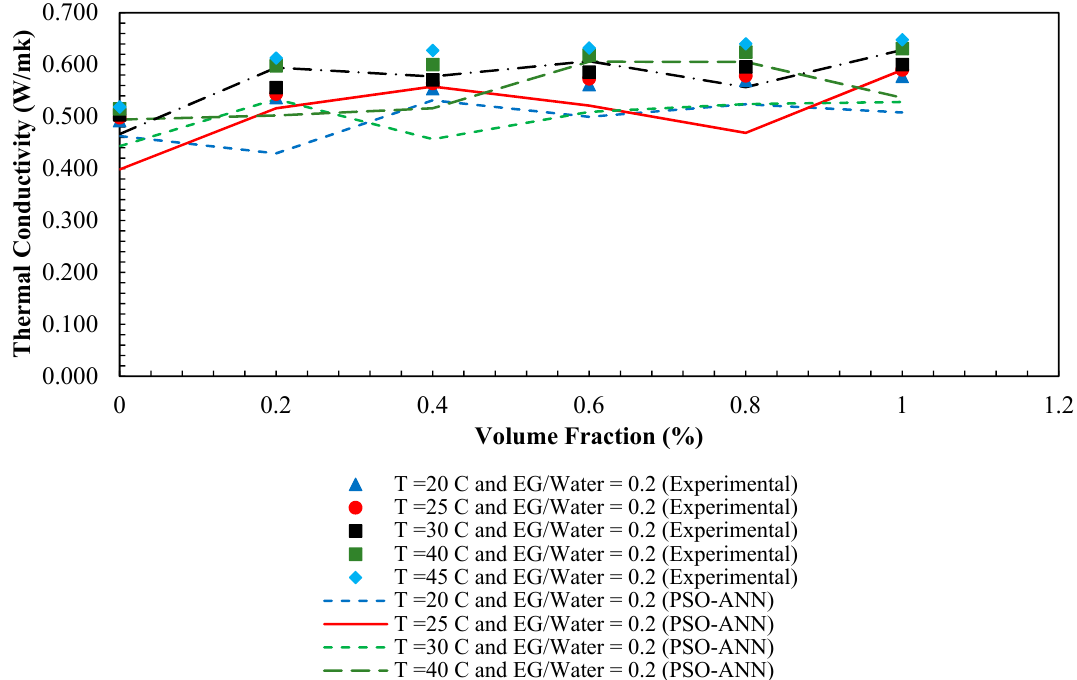
Volume Fraction (%) T =20 C and EG/Water = 0.2 (Experimental) T =25 C and EG/Water = 0.2 (Experimental)